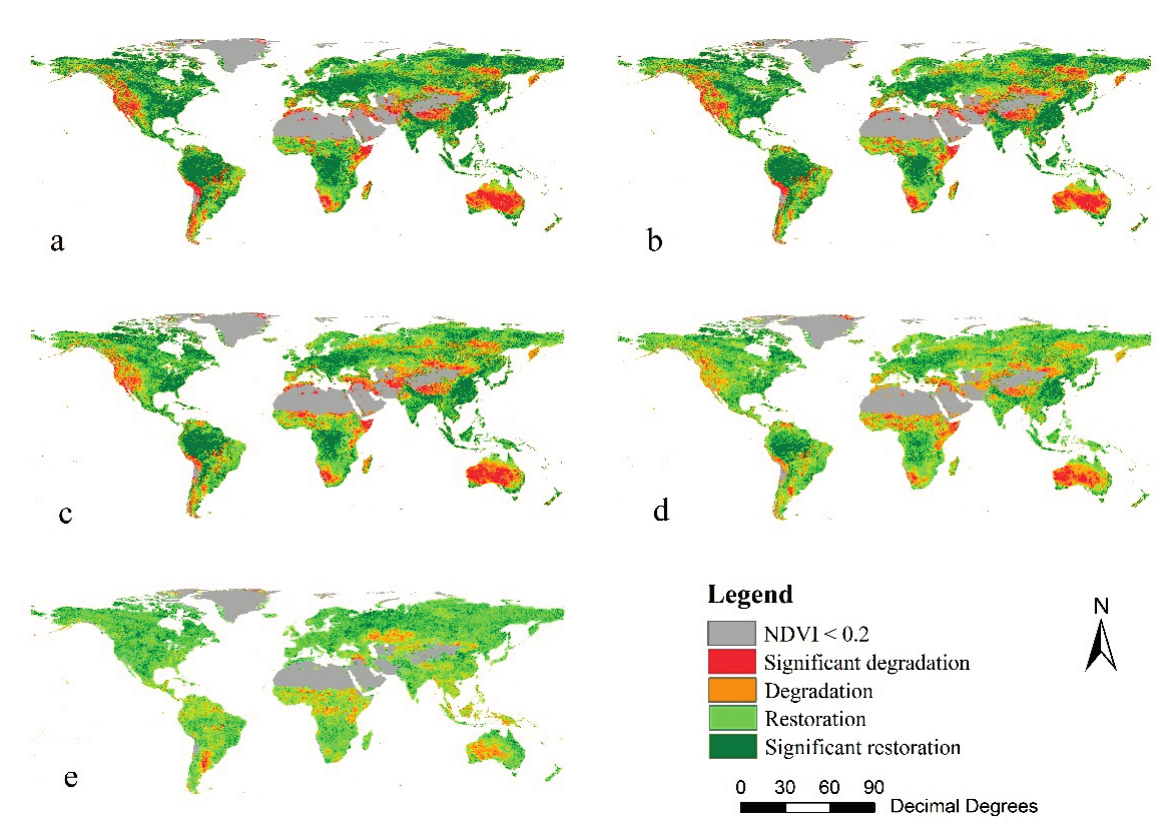
Figure 5. Global land vegetation degradation and restoration trends indicated